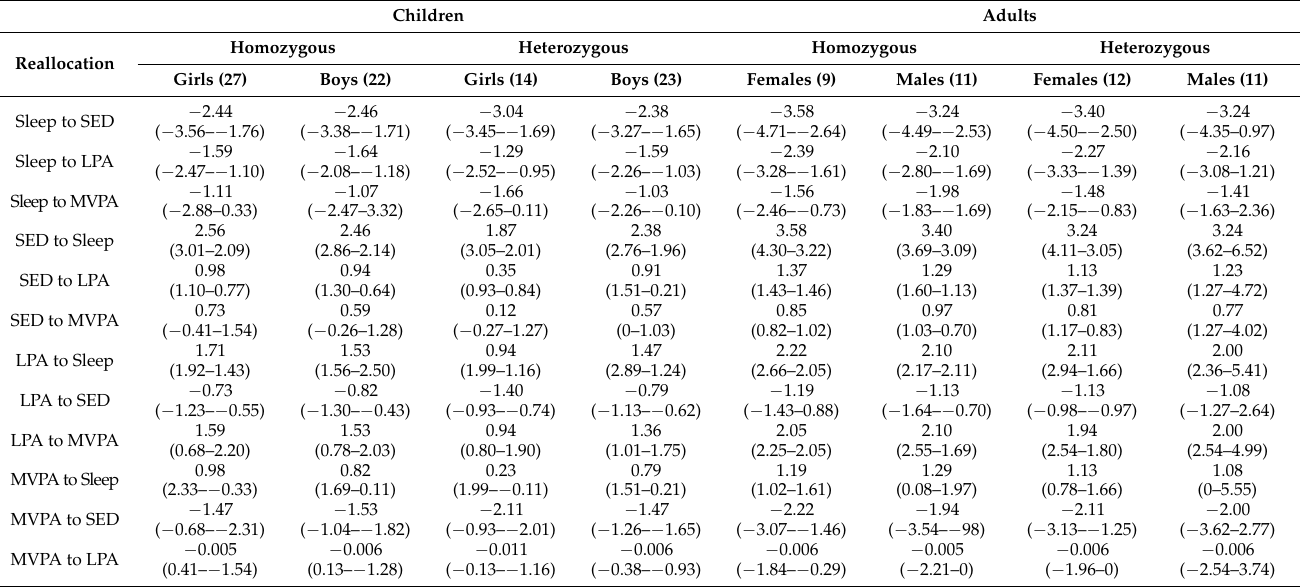
Table 5. Percentage change values of FEV 1%predicted when reallocating 30 min amongst different movement behaviours, stratified by sex, genotype and age in children and